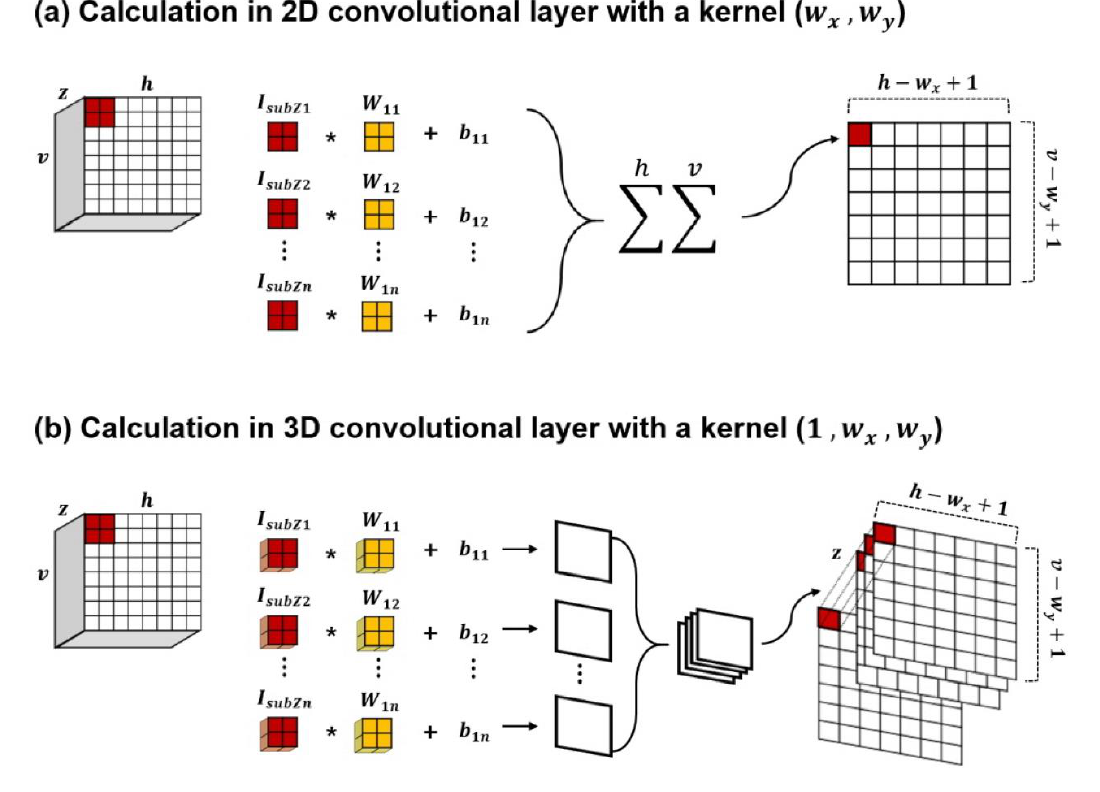
Figure 4. Summary of how calculations in 2D-CNNs and 3D-CNNs are conducted. The 𝐡 , 𝐯 and 𝐳 mean horizontal, vertical, and depth scale of input data, respectively. The set of 𝑰 𝒔𝒖𝒃𝒁𝒏 is the segmented features of input data through convolution. 𝐖 and 𝐛 are the weight and bias which are applied to 𝑰 𝒔𝒖𝒃𝒁𝒏 . The size of the output is determined by the filter and pooling layer size.